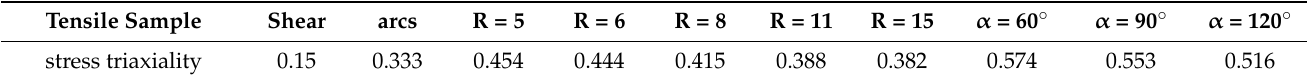
Figure 7. Stress triaxiality distribution of 6061 aluminum alloy tensile sample. ( a ) Shear sample. ( b ) Circular arc tensile sample. ( c ) Arc-shaped notched tension sample. ( d ) V-shaped notched tensile sample. Table 1. Stress triaxiality of the tensile sample.